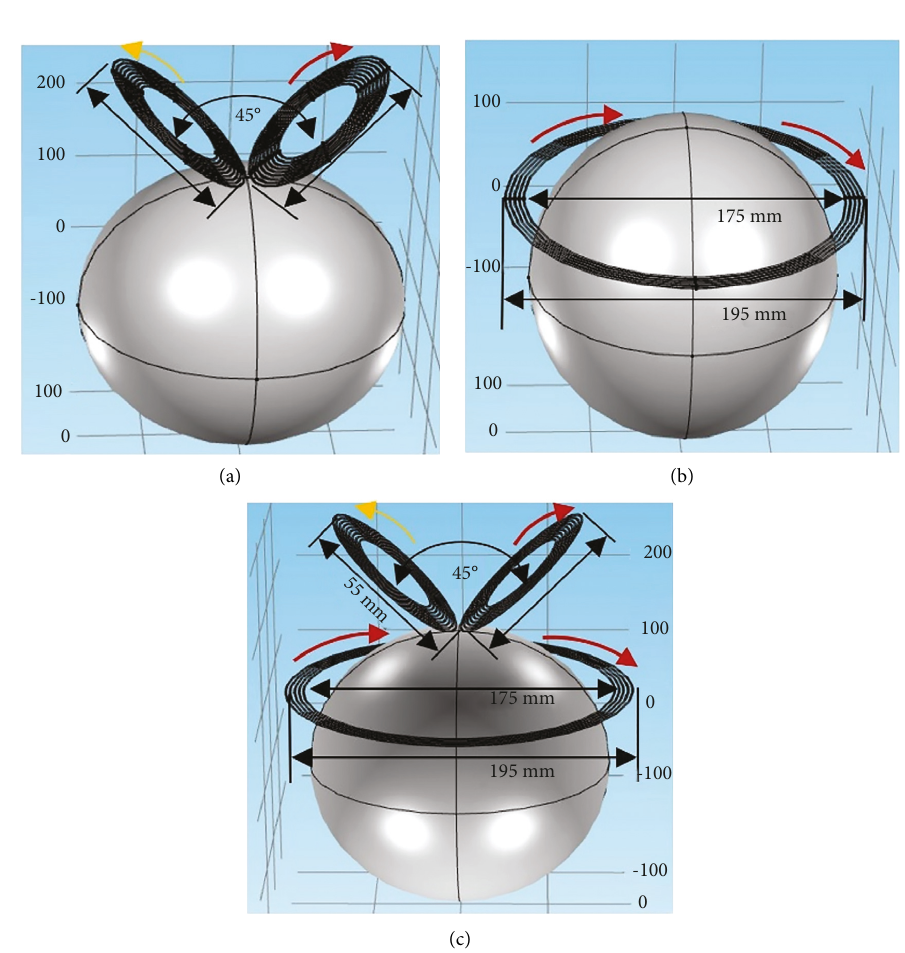
Figure 2: Geometrical structure of coils. (a) V coil. (b) Halo coil. (c) HVA coil. The red arrow line indicates the clockwise current direction and the yellow arrow line indicates the anticlockwise current direction.